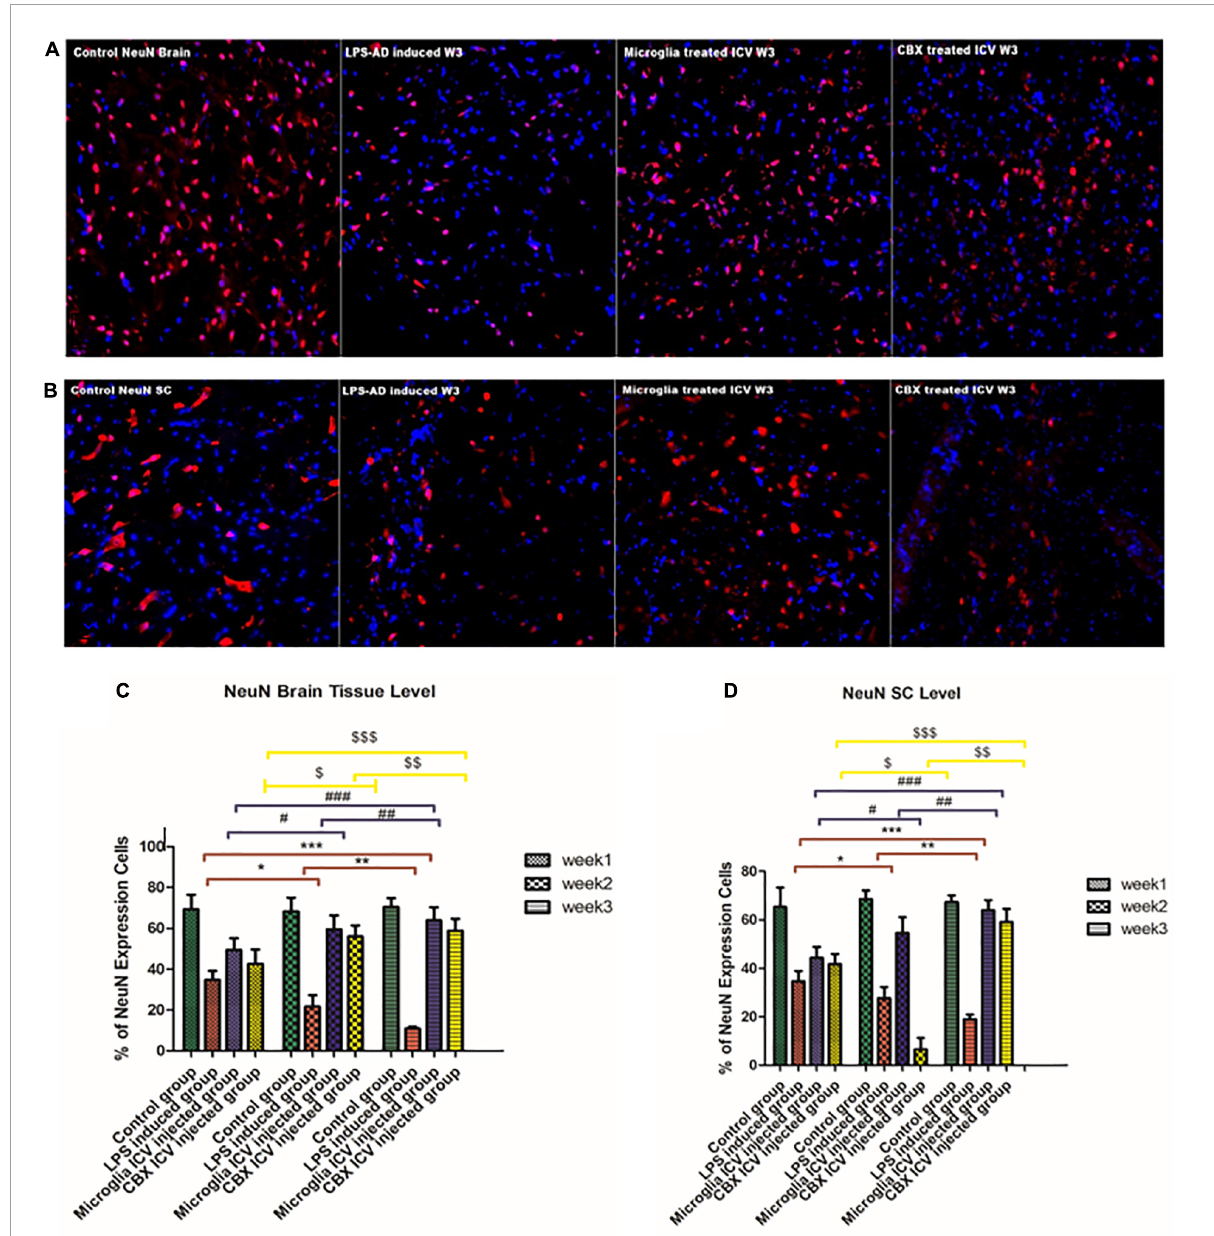
FIGURE10 Detection of NeuN expression level in the cerebral cortex (A) and the spinal cord (B) of the lipopolysaccharide (LPS)-induced rats and following the single intracerebroventricular (ICV) administration of primary healthy microglia (PHM) and carbenoxolone (CBX) (week 3). Decreased NeuN cell expression was detected in the cerebral cortex and spinal cord sections of the LPS-induced AD neuroinflammatory model. Meanwhile, an observed increase in the percentage of the NeuN expression level was detected in the cerebral cortex and spinal cord sections following the single ICV administration of primary healthy microglia (PHM) and CBX (week 3). (C) Illustration of NeuN% expression cells level and quantitative analysis in the cerebral cortex over the 3-week time interval. (D) Illustration of GFAP % expression cells level and quantitative analysis in the spinal cord over the 3-week time interval. Represented data were expressed as mean ± SD ( n = 6 per group) (ANOVA, repeated measurement, Bonferroni post-hoc test, p < 0.05). The same asterisks represent an insignificant difference p >